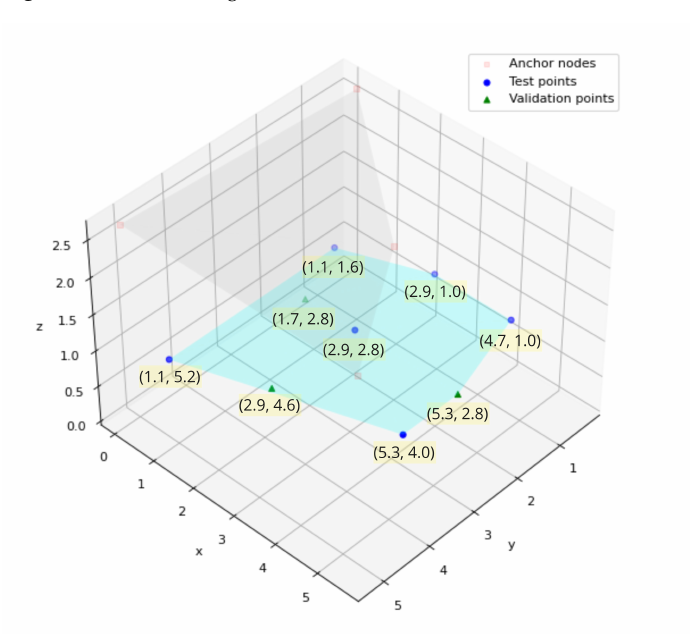
Figure 7. Packet sorting routine.